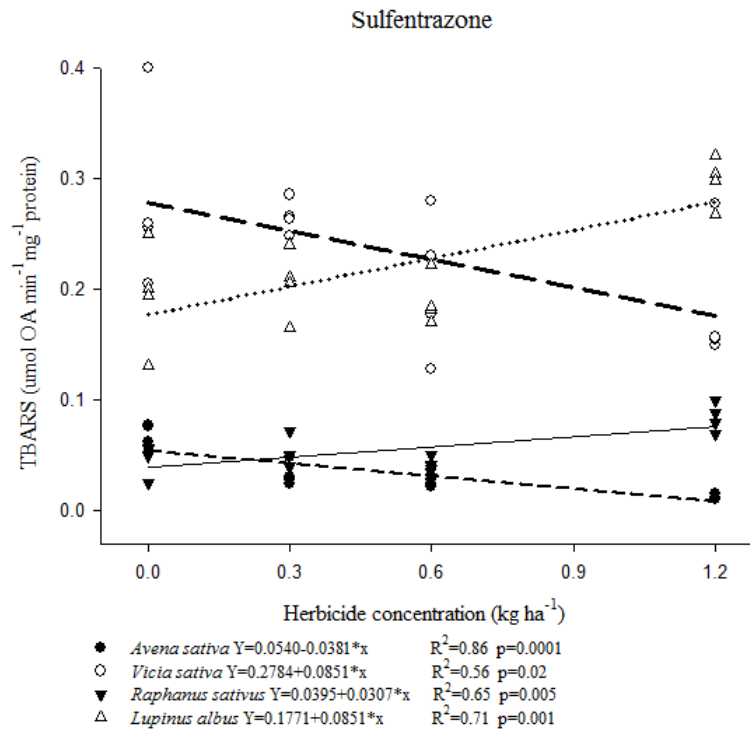
Figure 6 - Effect of sulfentrazone on lipid peroxidation in different crop